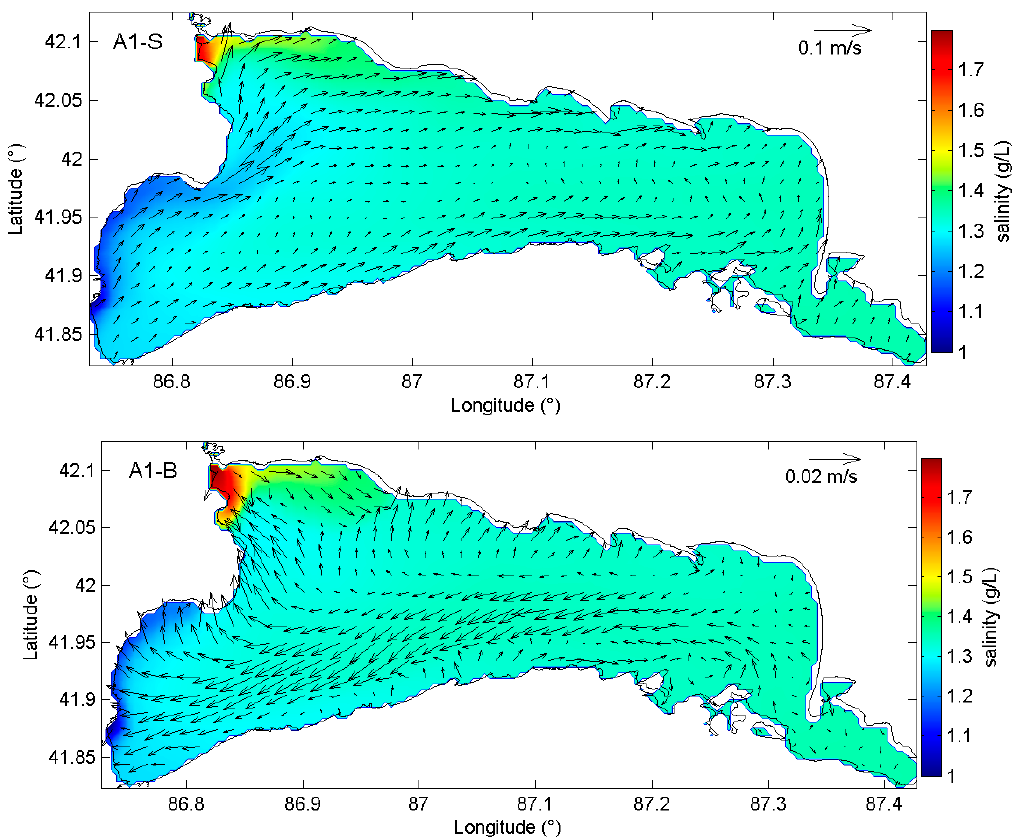
Figure 8. Distribution of simulated residual currents and salinity ( A1-S ) at the surface, and ( A1-B ) in the bottom layer in experiment A1. The simulated currents are shown at every third model grid point.